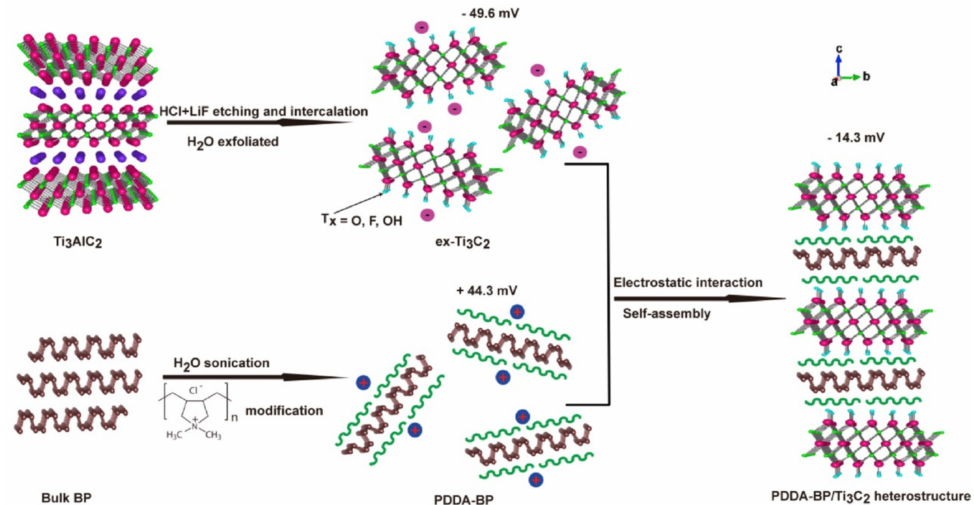
Figure 5. Schematic diagram of the synthesis process of PDDA − BP/Ti 3 C 2 heterostructures. Reprinted with permission from Ref. [79]. 2019,